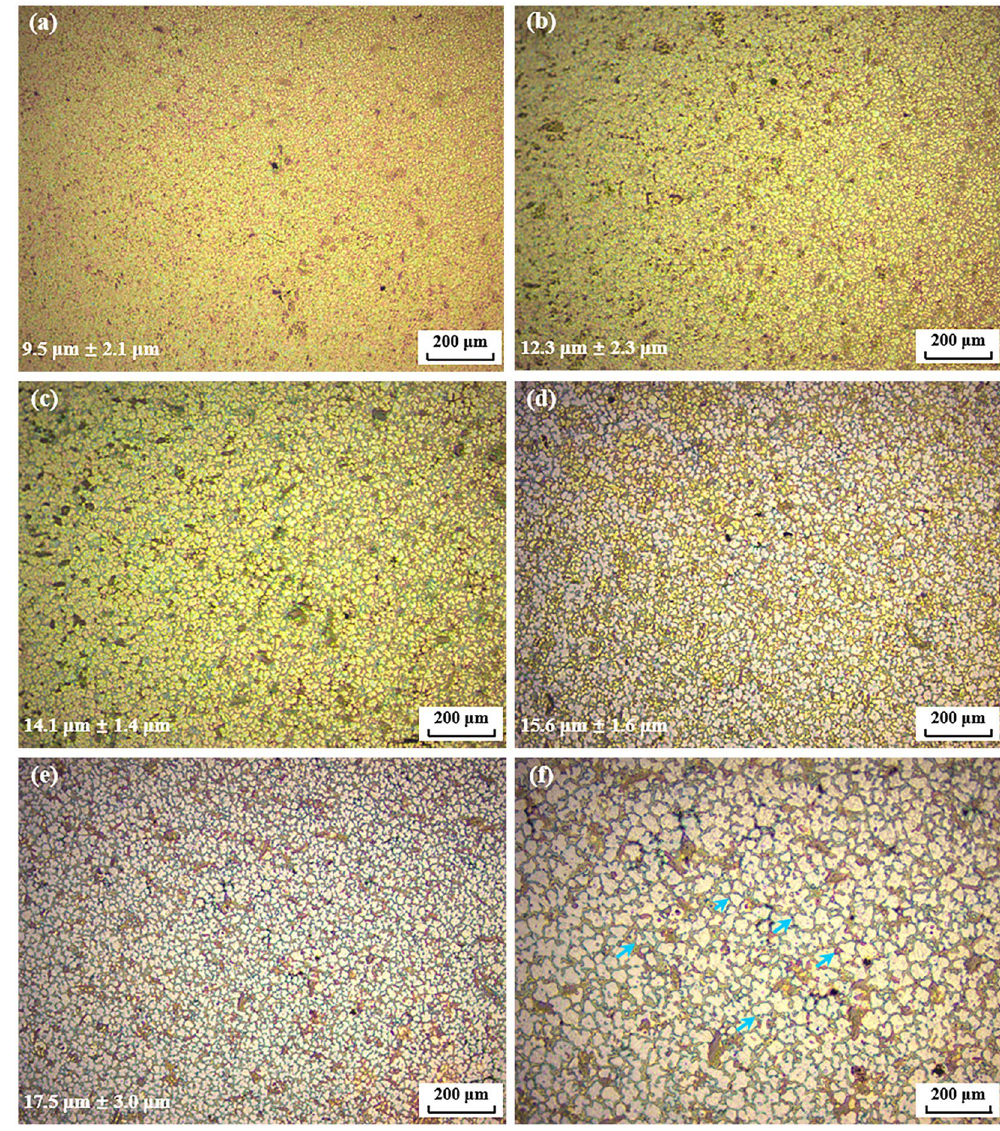
Figure 2. Typical microstructures of nano-treated AA7075 with TiC NPs under varied cooling rates. ( a ) 197.5 K/s; ( b ) 87.8 K/s; ( c ) 29.5 K/s; ( d ) 20.3 K/s; ( e , f ) 14.8